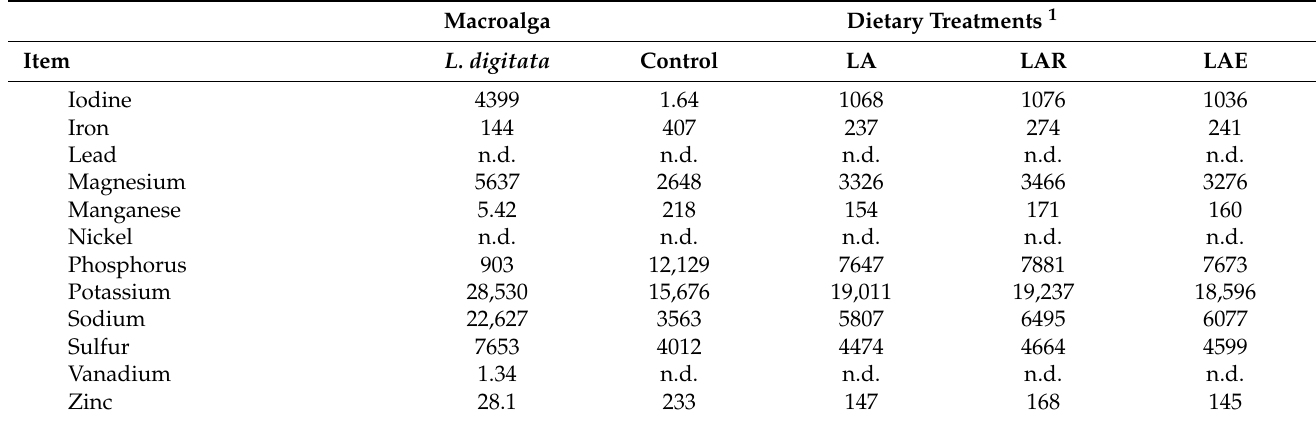
Table 2. Cont. Macroalga Dietary Treatments